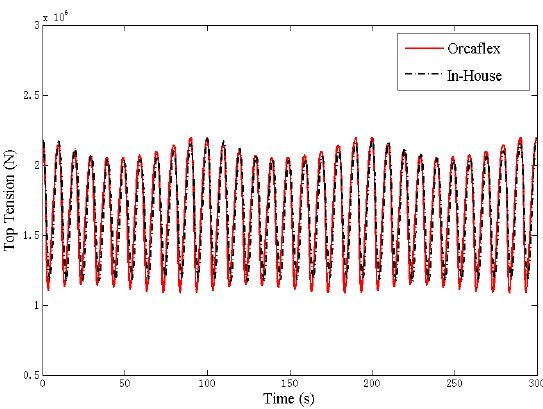
Figure 5. Single mooring line under the combined vertical and horizontal harmonic excitations.